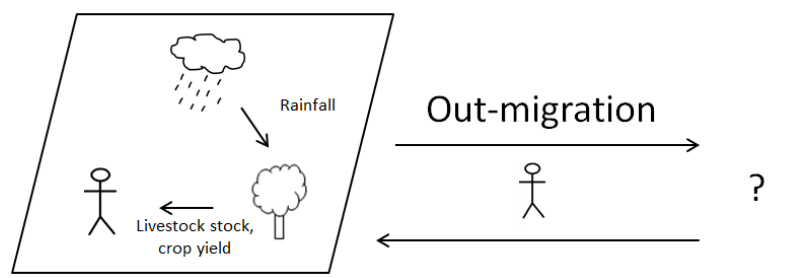
Fig. A1.13 Diagram drafted for the ABM described by Smith (2014); migrants send remittances back to their household and are therefore not deleted from the system (i.e. this is not „migration out of the system“)